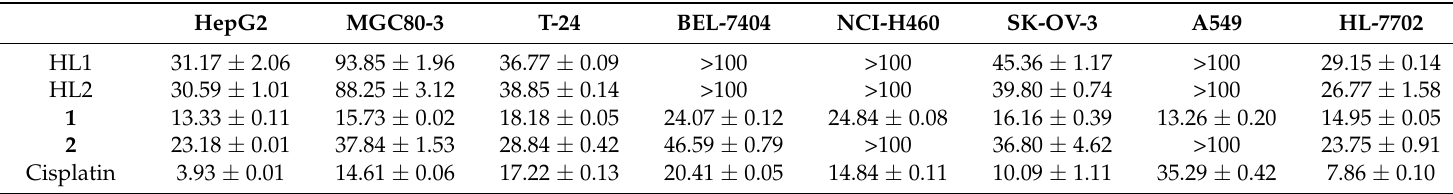
Table 8. IC 50 values of HL1, HL2, 1 and 2 on different cell lines in